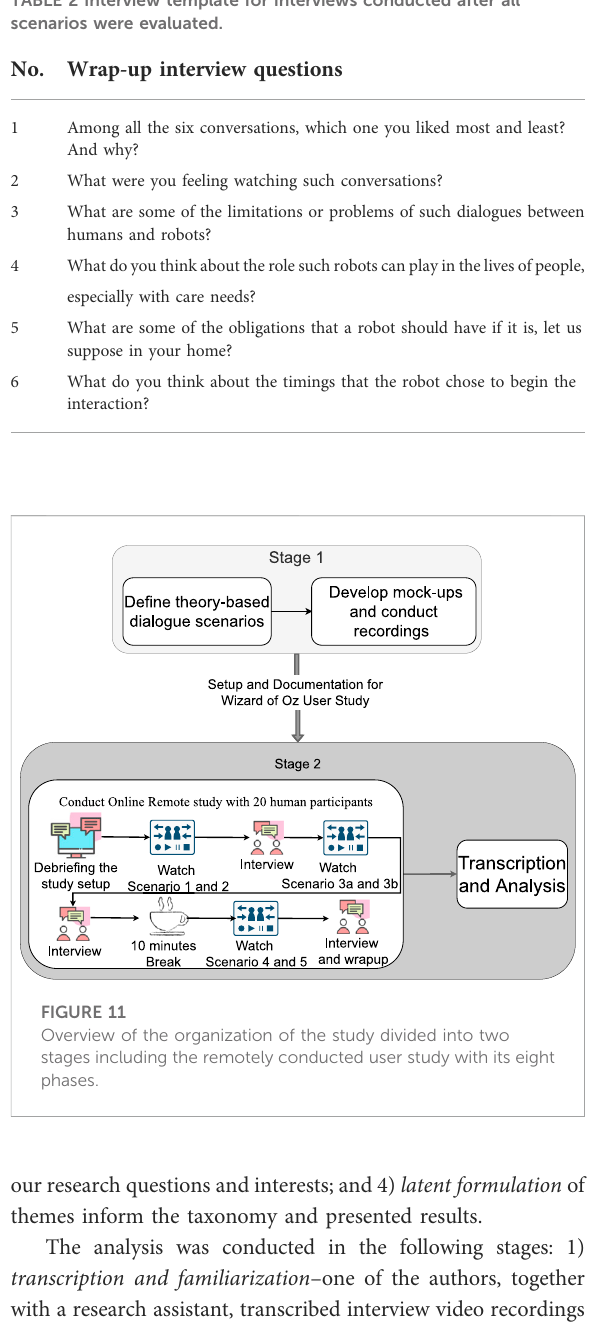
TABLE 2 Interview template for interviews conducted after all scenarios were evaluated.